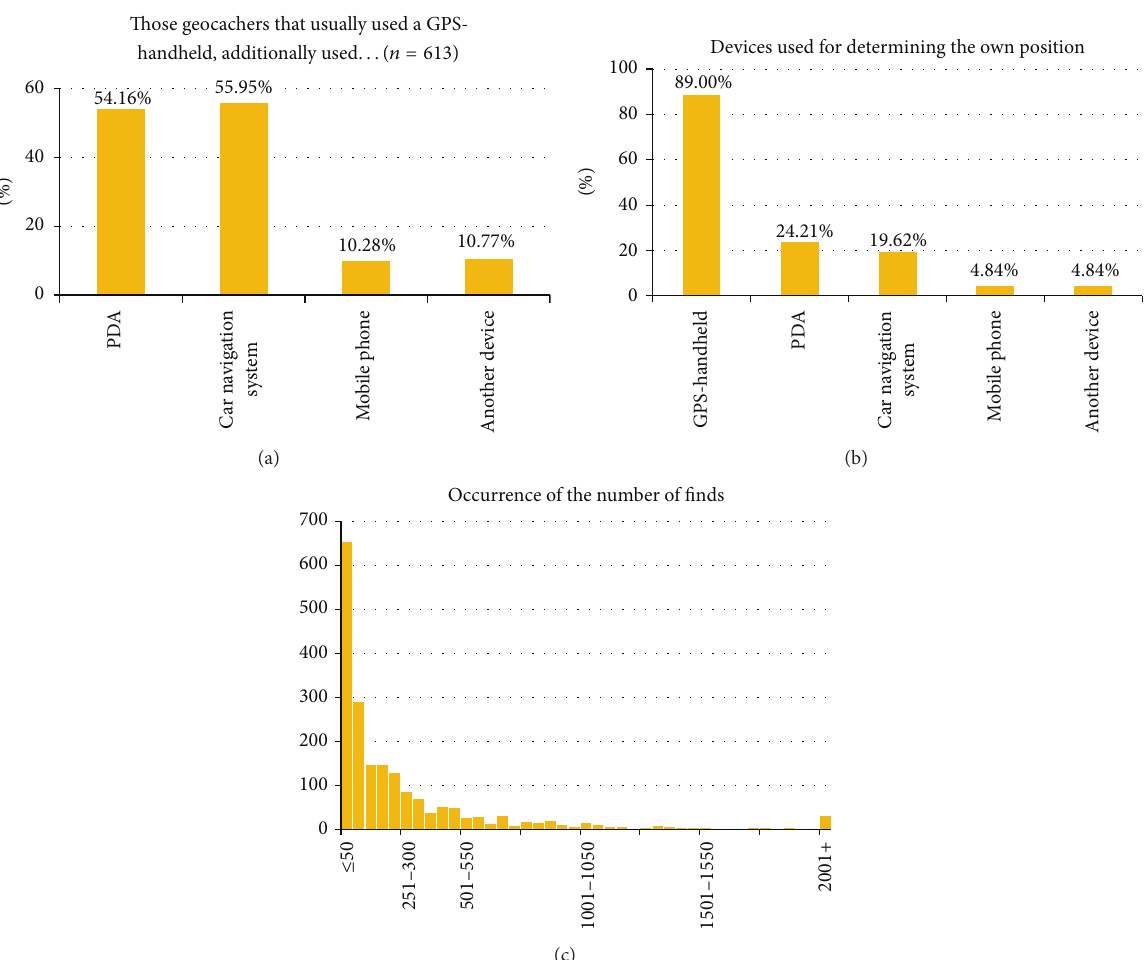
Figure 3: Histogram of numbers of caches found (a), devices used for determining the users position (b), and additional used devices and artefacts by the cachers